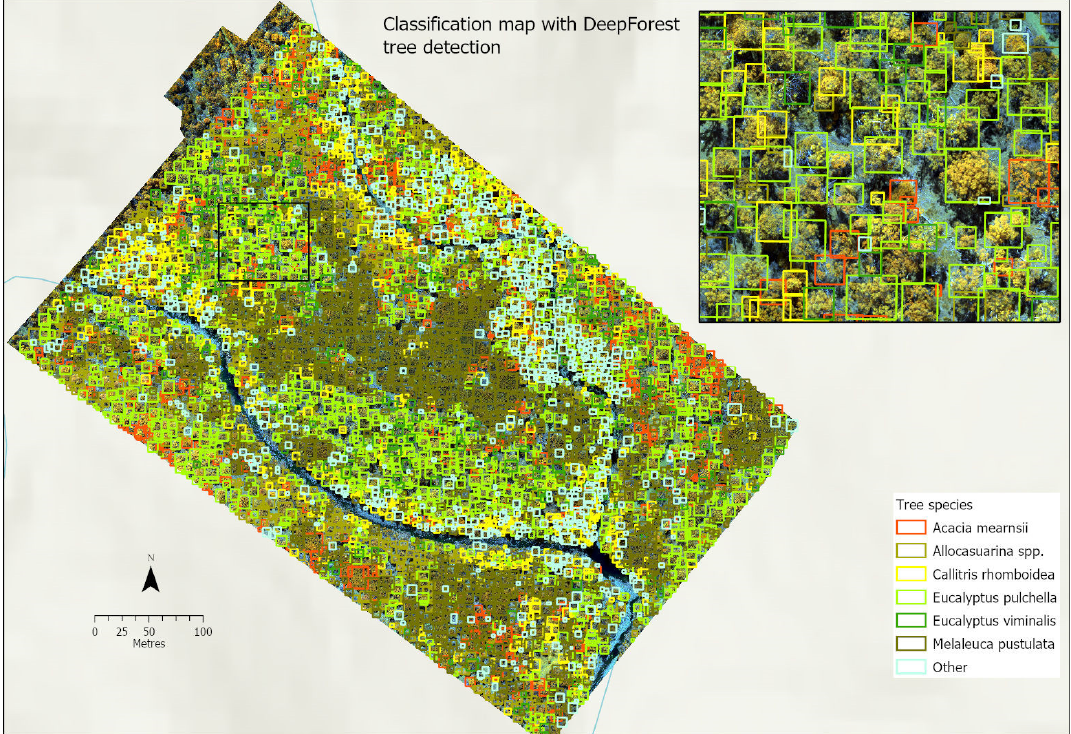
Figure 10. Classification map using DeepForest bounding boxes. Pulchella dominated forest subset shown in inset. Canopy edges falsely detected as individual trees. shown in inset. Canopy edges falsely detected as individual